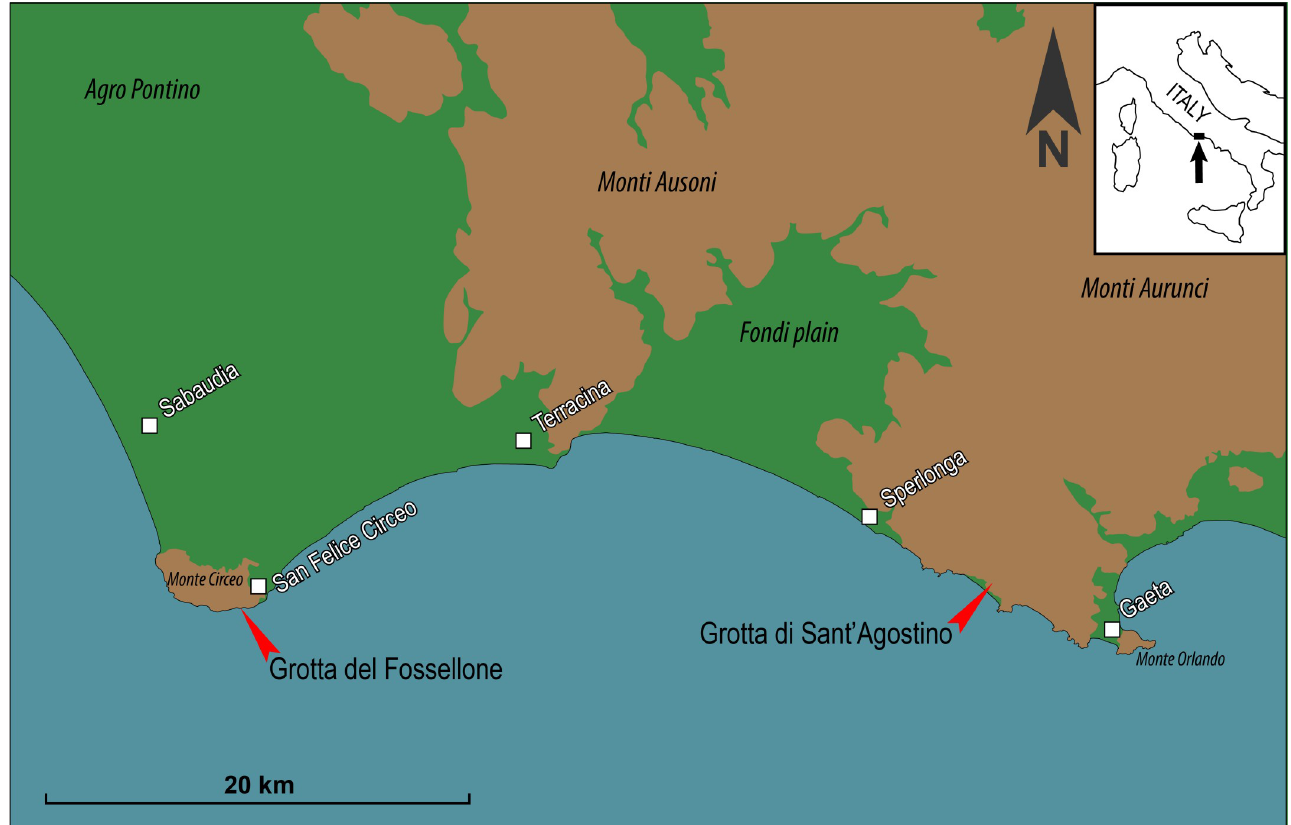
Fig 1. Map of Grotta del Fossellone (41˚13’26.29” N; 13˚04’50.53” E) and Grotta di Sant’Agostino (41˚14’01” N; 13˚30’13.08” E).